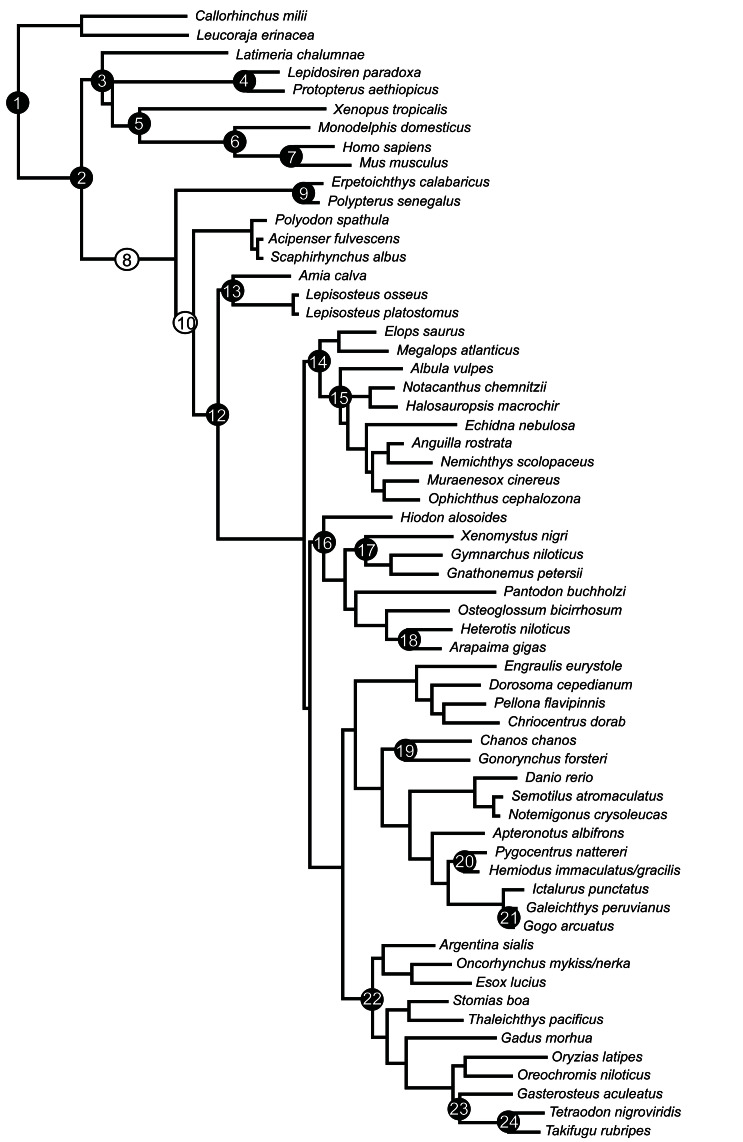
Numbers in circles correspond to numbered descriptions in text below. Black circles indicate crown calibrations; white circles indicate stem calibrations.